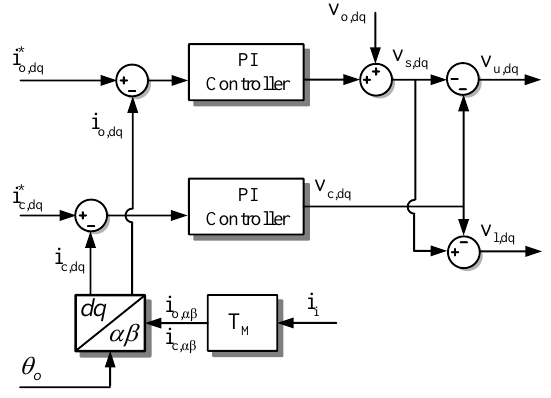
Figure 3. Decoupled current control of the